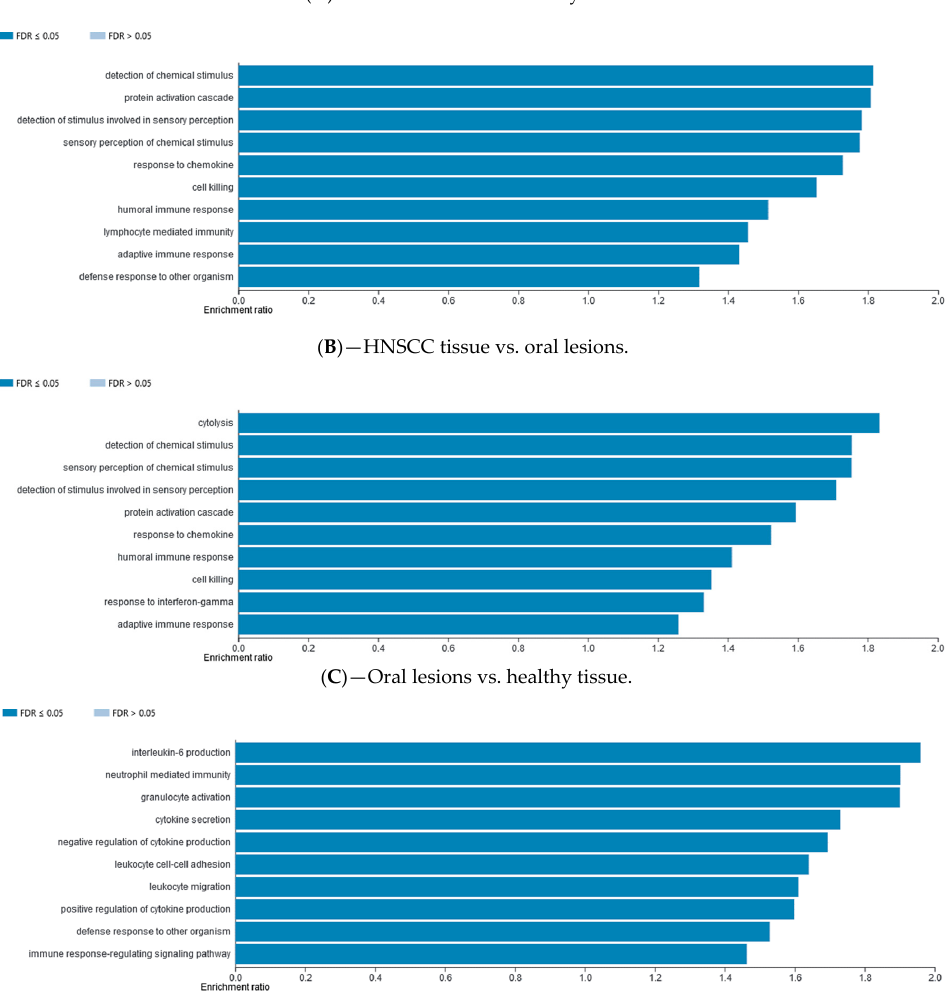
Figure 4. Over-representation enrichment analysis (ORA) of gene ontology (GO), biological processes, for consistently hypomethylated gene promoters and/or CpG sites in ( A ) HNSCC tissue compared to control healthy tissue, ( B ) HNSCC tissue compared to potentially premalignant oral lesions, and ( C ) potentially premalignant oral lesions compared to control healthy tissue. The top 10 categories are shown; the fold discovery rate (FDR) adjusted significance (colored bar) is in each shown case ≤ 0.05.